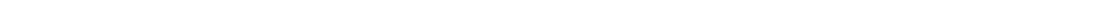
Fig. 6 ITS2 forms a very compact structure. a Overview of the various proposed secondary structure models for ITS2 17, 40, 41 . Roman numerals indicate the regions discussed in the main text. Dots of different colors represent nucleotides with SHAPE reactivity ≥ 0.4 in ITS2 primer extension data ( red ) and 35S and 27SA 2 particles ( dark blue ), 27SB particles ( light blue ), and deproteinized samples ( magenta ) based on ChemModSeq data. Note that the primer extension results for the 3 ′ end are not shown as this region showed high variability in reactivity. The known binding sites for assembly factors that interact with ITS2 are highlighted in the ring-pin model. b Heat map representing the ChemModSeq 1M7 reactivities. Each block indicates a single nucleotide. The darker the block the higher the 1M7 reactivity. c Primer extension analysis of the 5 ′ end of ITS2 and the 3 ′ end of 5.8S region and line scans of the signal intensities of each lane. d RNA structure probing data agrees well with the cryo-EM structure of ITS2 fragments. Shown is the secondary structure of parts of ITS2 that were resolved by cryo-EM 12 . The black nucleotides in the sequence are nucleotides that are either base-paired or bound by assembly factors in the structure. Gray nucleotides are predicted to be single-stranded as they are not involved in Watson – Crick or Hoogsteen base-pairing interactions and are not predicted to be bound by